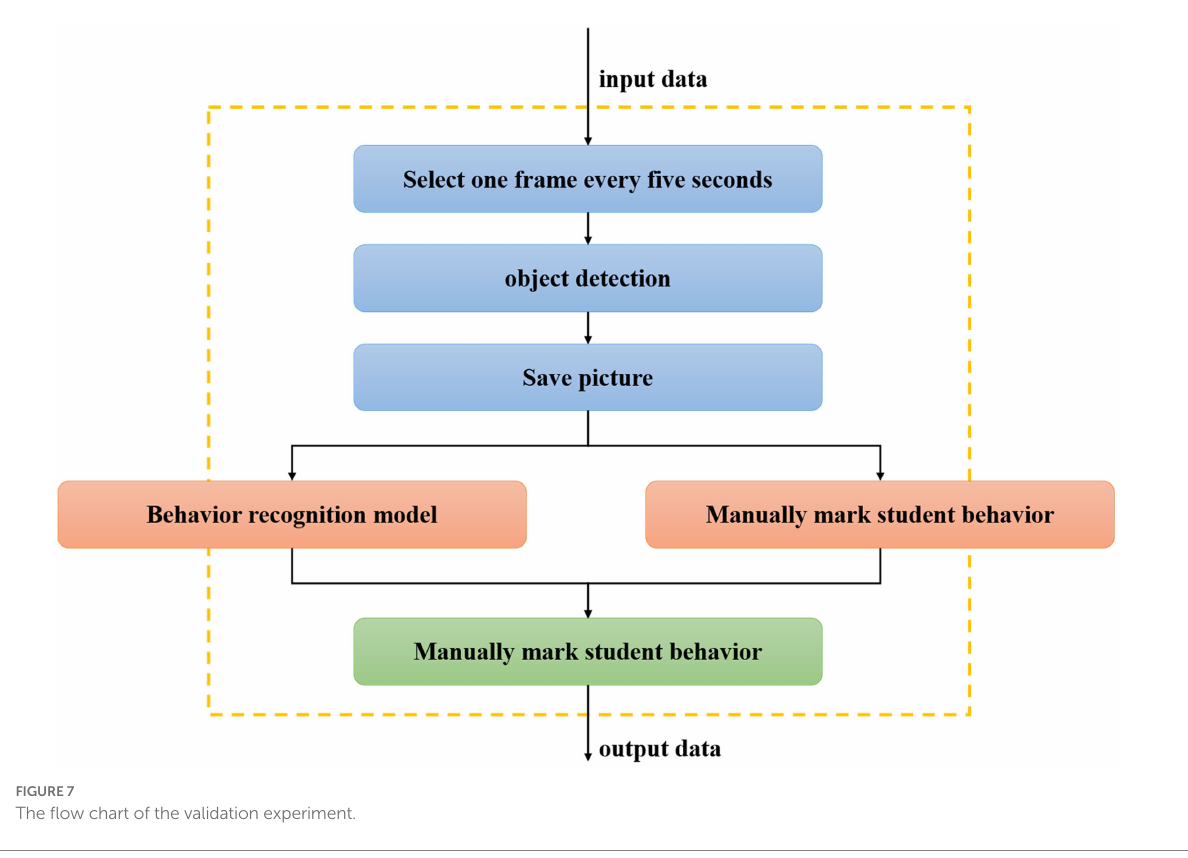
FIGURE 7 The flow chart of the validation